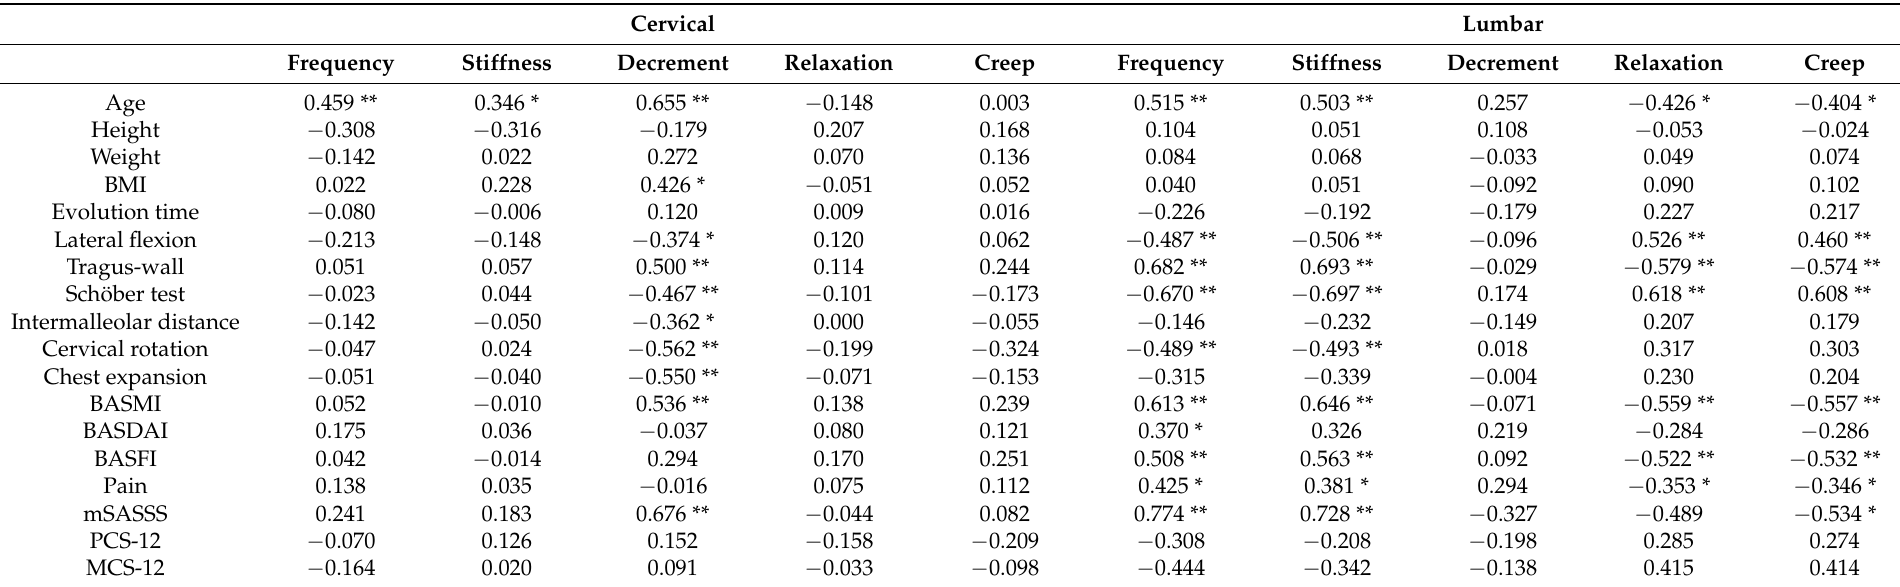
Table 3. Bivariate correlations (Pearson) between muscle tone measurements and other measured variables in axSpA